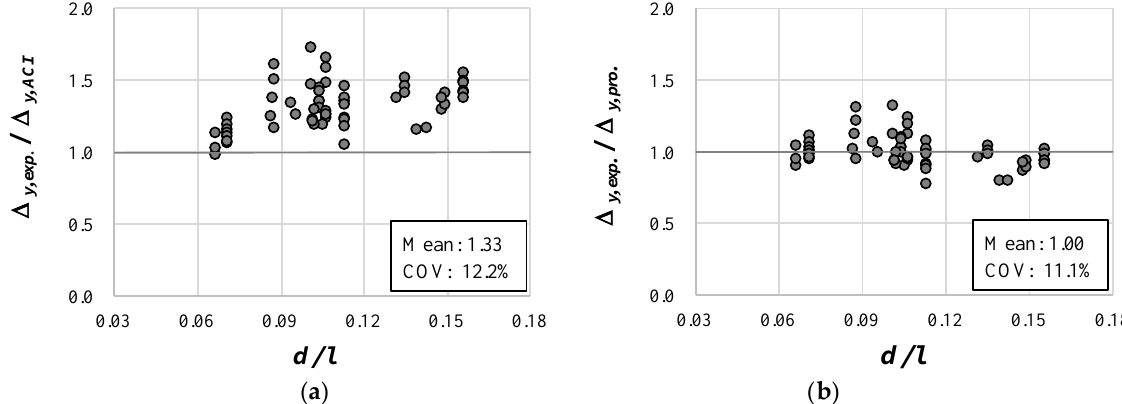
Figure 9. Prediction results of analytical methods on deflection at flexural yield: ( a ) ACI 318-19; ( b ) Proposed method.